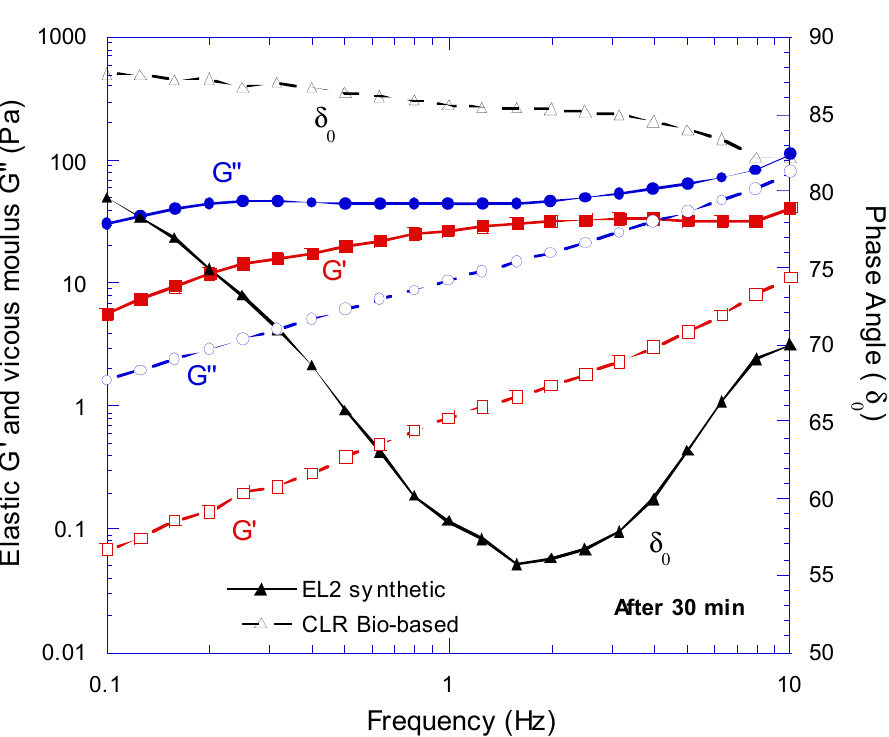
Figure 10. Comparison of frequency sweep test results of CLR bio-based (dash lines) and EL2 synthetic (solid lines) epoxies after 30 min of hardener mixing.